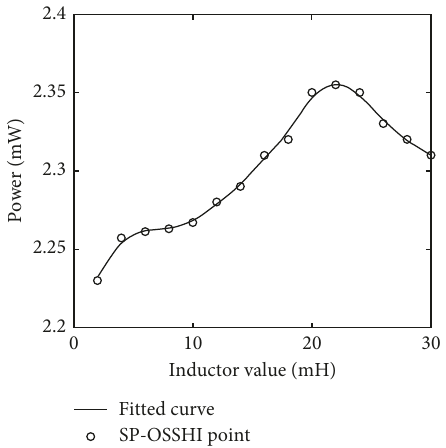
Figure 9: Inductor-power simulation waveform.